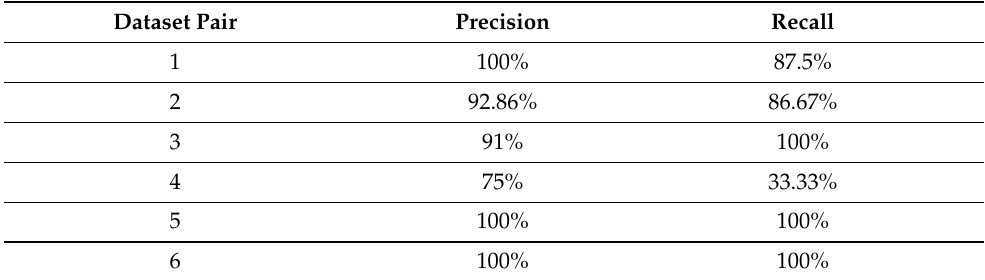
Table 2. Best Results of Dumas